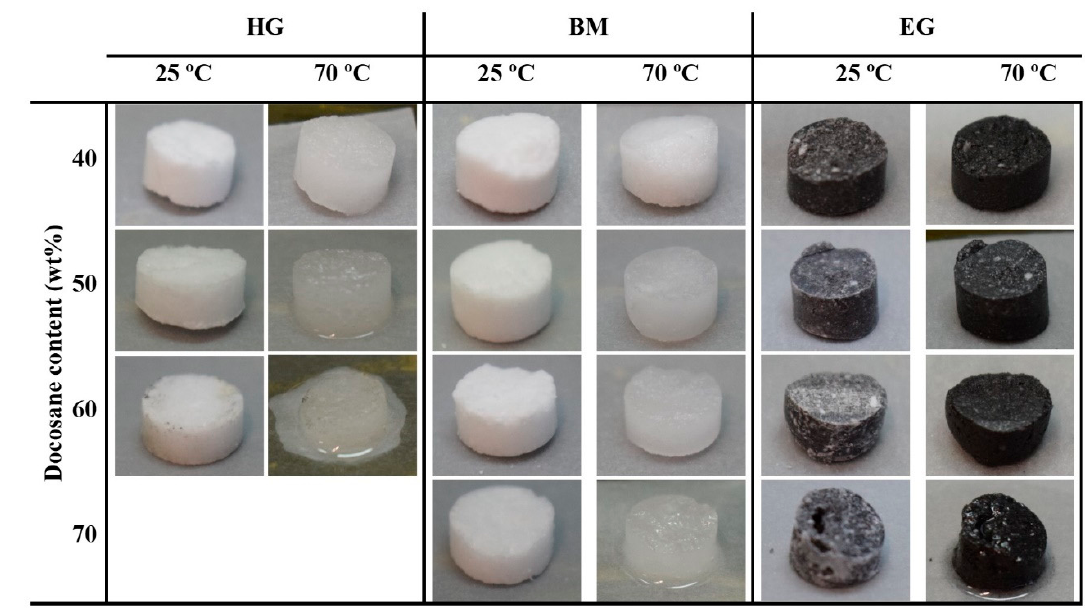
Figure 4. Obtained NPG-Docosane samples at 25 °C (left) and after 1 h at 70 °C (right).